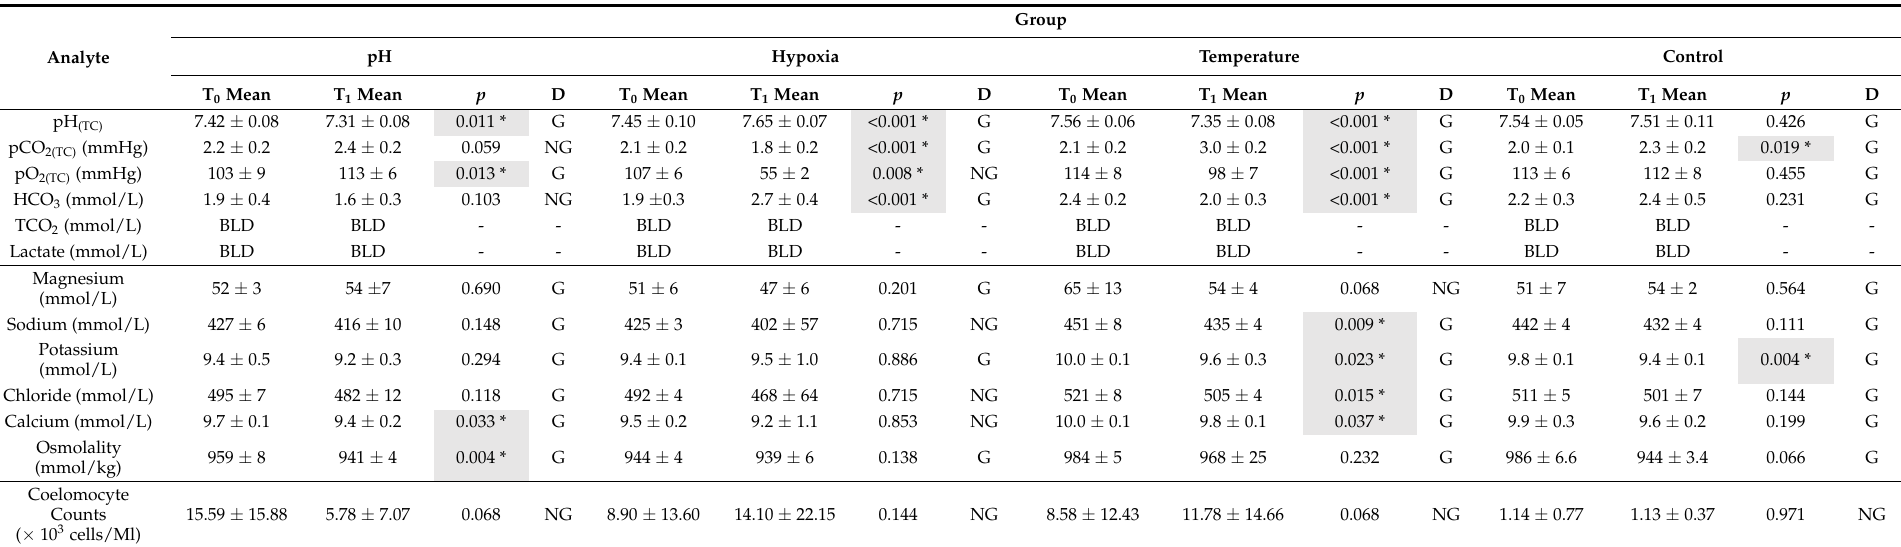
Table 4. Mean ± standard deviation for blood gases ( n = 10 animals each in pH, temperature; and control groups; hypoxia group had 9 animals), electrolytes ( n = 4 animals per group), osmolality ( n = 4 animals per group) and coelomocyte counts ( n = 4 animals per group) in coelomic fluid of common sea stars (